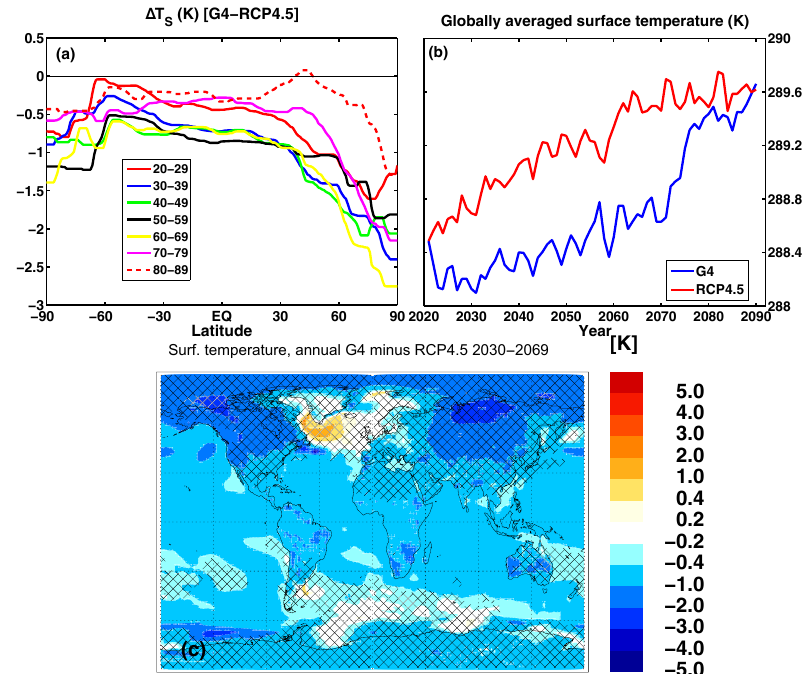
Figure 6. (a) Zonally averaged surface temperature changes G4-RCP4.5 (K) in the ULAQ-CCM (cases a and b), using sea surface tem- peratures from the atmosphere–ocean coupled model CCSM-CAM4 (decadal time averages from 2020 to 2089; see legend for the different colors). (b) Time series of the globally averaged surface temperatures (K) from 2020 to 2090 (RCP4.5 in red and G4 in blue). (c) Annually av- eraged surface temperature anomalies G4-RCP4.5 (K) from the atmosphere–ocean coupled model CCSM-CAM4 (time average 2030–2069). Shaded areas are not statistically significant within ± 1 σ